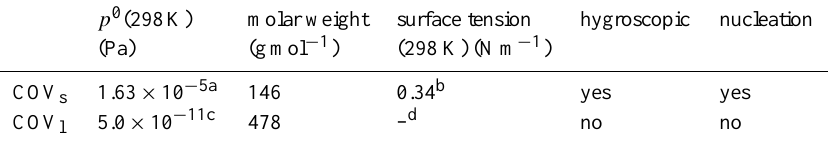
Table 2. Physical properties of the condensable vapours. COV s was used in AEROFOR, whereas COV s and COV l were used in MAFOR. p 0 (298K) molar weight surface